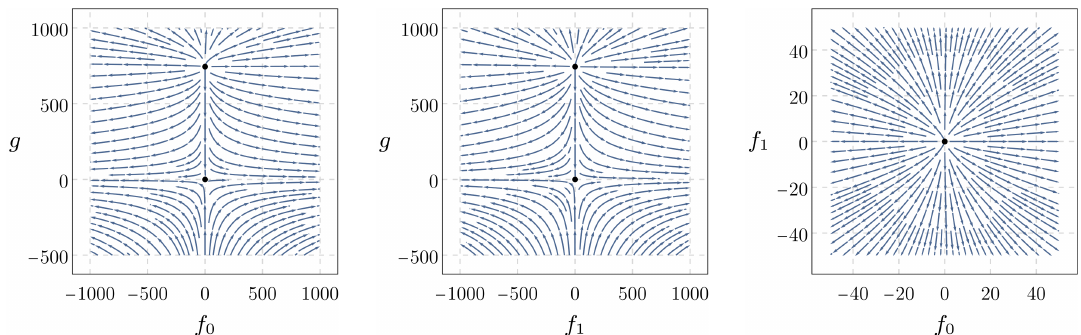
Figure 4 . Projection of the RG flow of F k and g k on the theory sub-spaces spanned by ( g, f 0 ) (left panel), ( g, f ) (central panel) and ( f ) (right panel), for d = 3 . The Gaussian and 1 0 , f 1